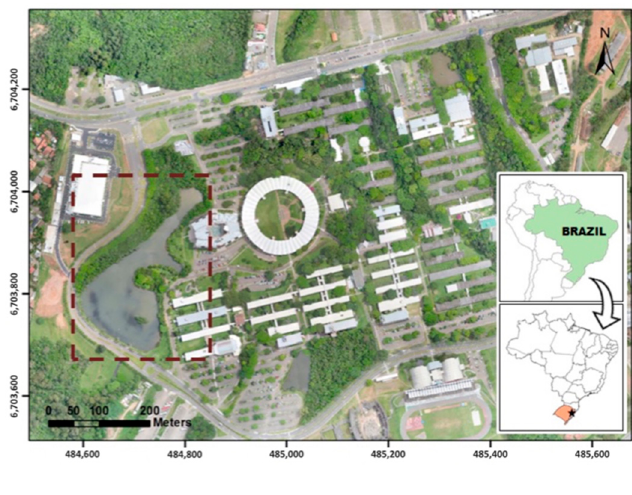
Figure 2. Study area.